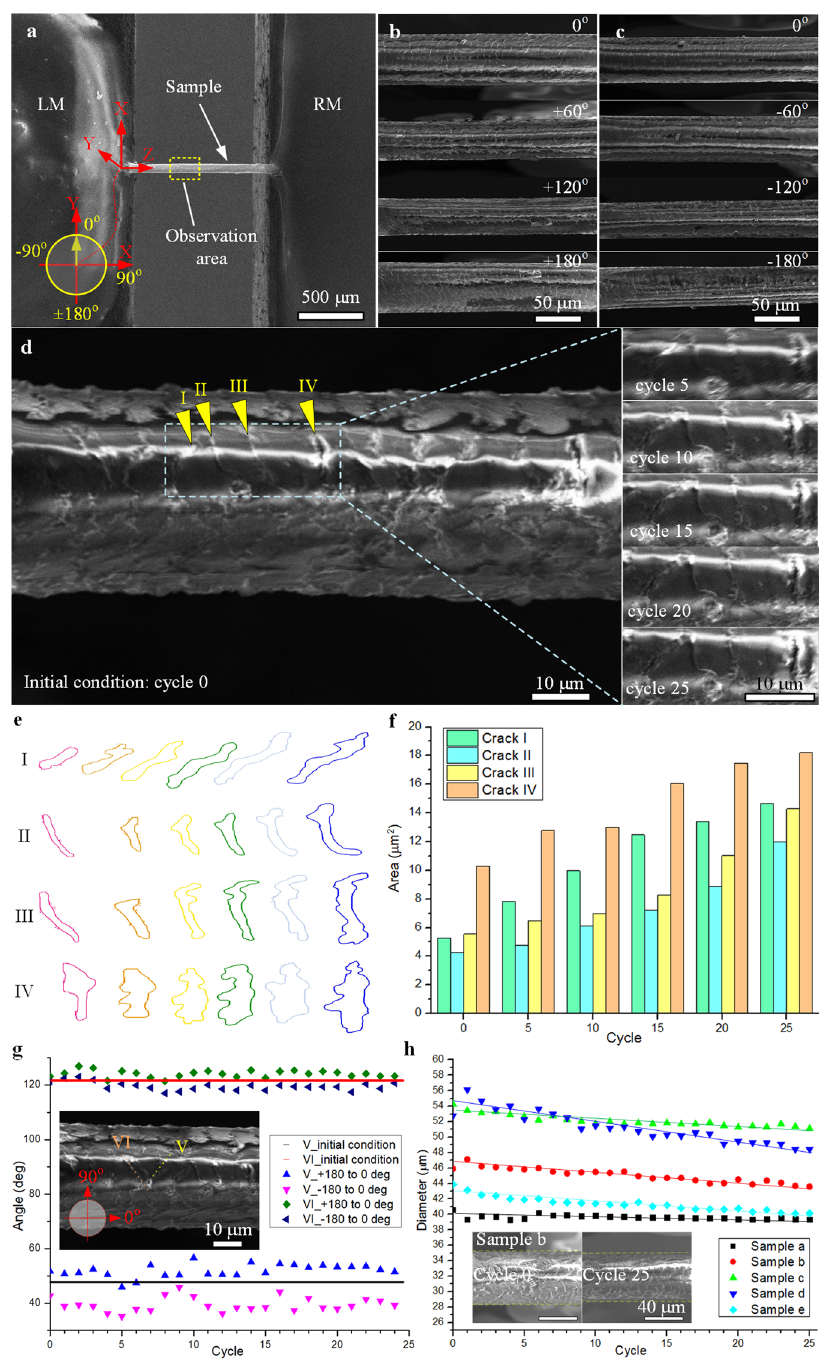
Figure 5. Twisting test of human hair. ( a ) The human hair is assembled on the two sample holders of iTRo with gauge length approximate 680 μ m. ( b ) and ( c ) selectively gives four SEM images of the sample while twisting from 0° to + 180° and 0° to − 180°, respectively. ( d ), ( e ) and ( f ) illustrate the shape change and area increase of the four cracks with increasing of twisting cycle. ( g ) gives the slop difference of the two cracks after the sample is twisting to 0° from + 180° and − 180° respectively, indicating the slow rebound phenomenal of human hair. ( h ) shows the diameter of human hair (five samples) decreasing gradually with increasing of twisting